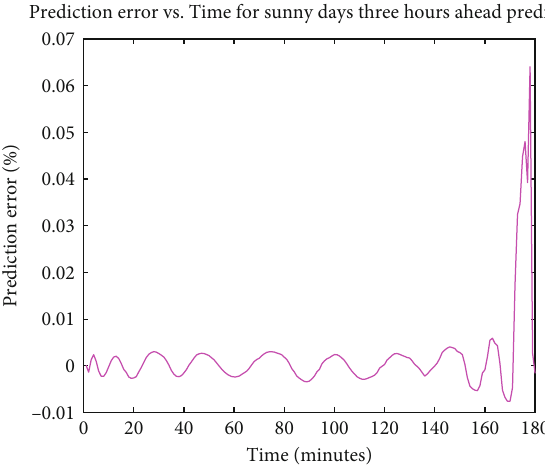
Figure 11: Prediction error vs. time for sunny day three-hour- ahead